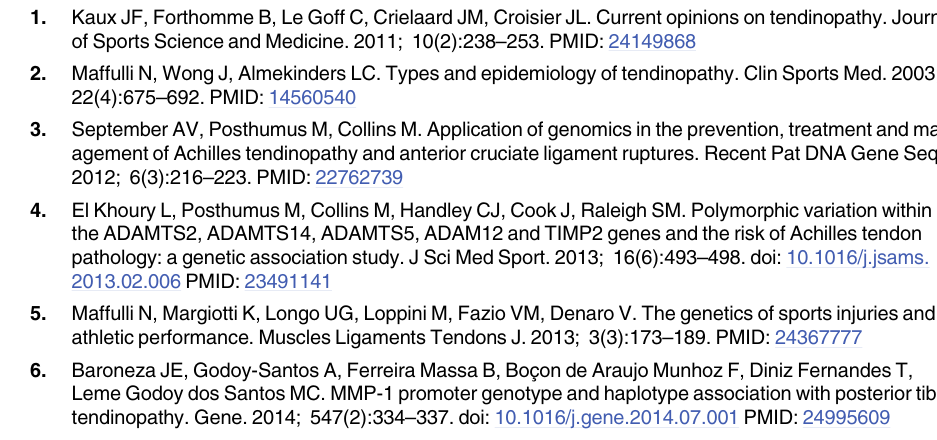
S1 Table. Overall data of study population. Demographic and clinical variables, and geno- types of VEGF and KDR in tendinopathy cases and controls. S2 Table. Haplotypes of VEGF and KDR in study